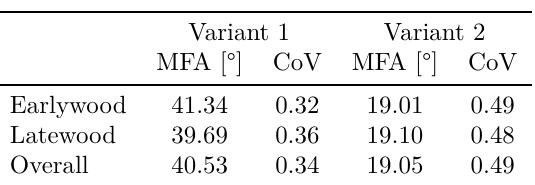
Table 3. Mean values of the MFA. (CoV = Coefficient of